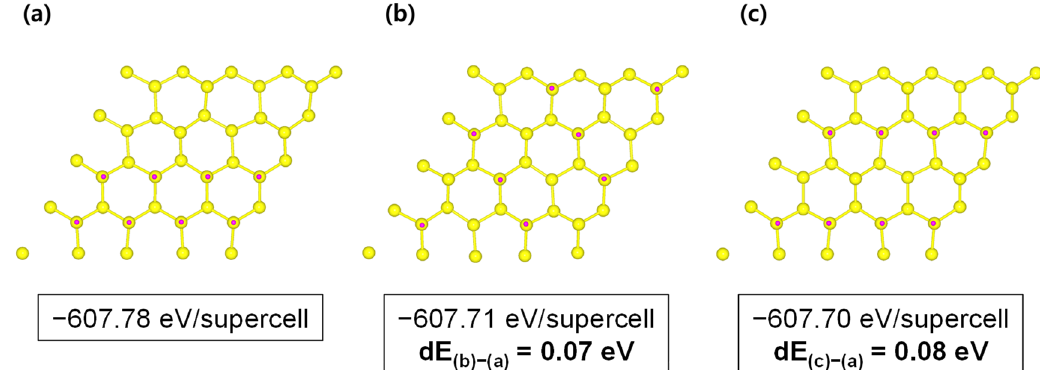
Figure 2. DFT calculation results describing most probable hydrogen configurations on top-layer of the H-50% covered Si(111) surface. Configuration ( a ): all adsorbed hydrogens are in close to each other. Configuration ( b , c ): all of the adsorbed hydrogens are slightly apart from the other hydrogens.